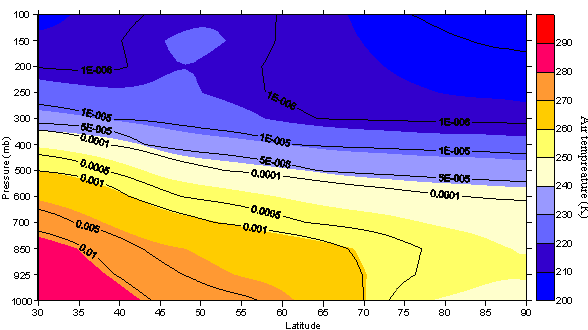
Fig. 5 Fig. 5. Vertical cross section of zonal-mean air temperature (K) (color-contoured) and temperature-dependent vapor pressure (Pa) of lindane (solid black line) from the surface to 100hPa, averaged over the period of 1–10 April 1997 and over longitude 110 ◦ E to 140 ◦